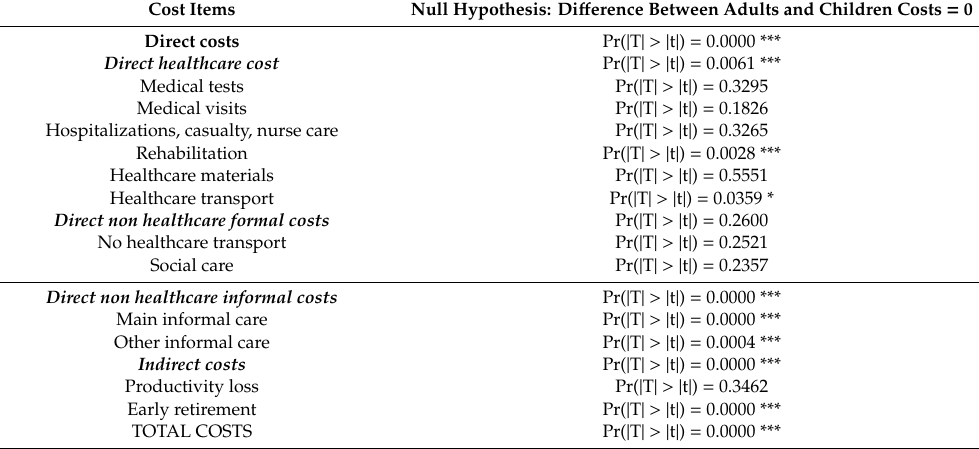
Table 6. Two-tailed t test with equal variances testing whether the cost di ff erences between adults and children are statistically